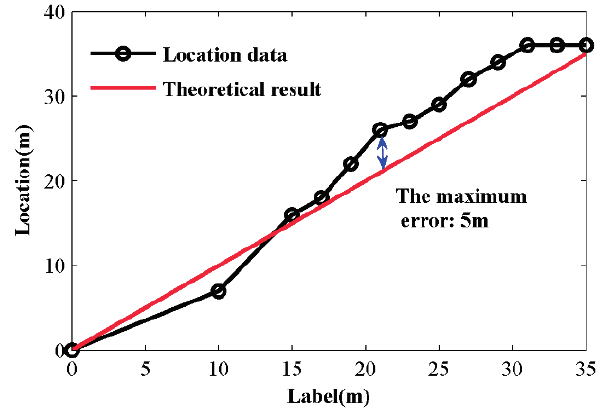
Figure 9. Average locating result under different perturbation points (the black line is the locating result and the red line is the reference